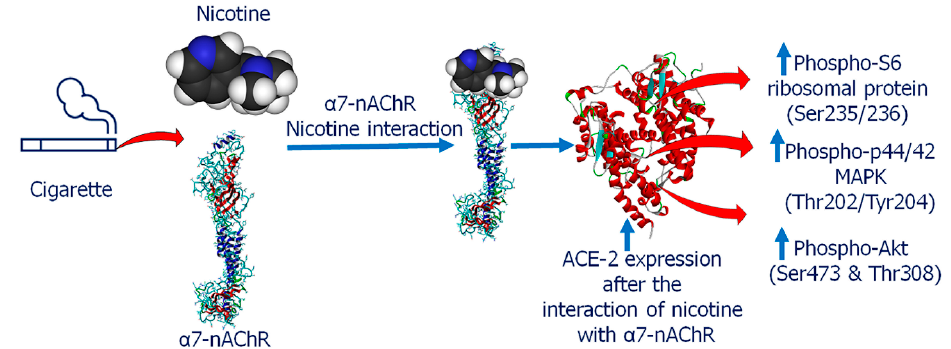
Figure 2. Schematic representation of SARS-CoV-2-driven signaling pathways induced by